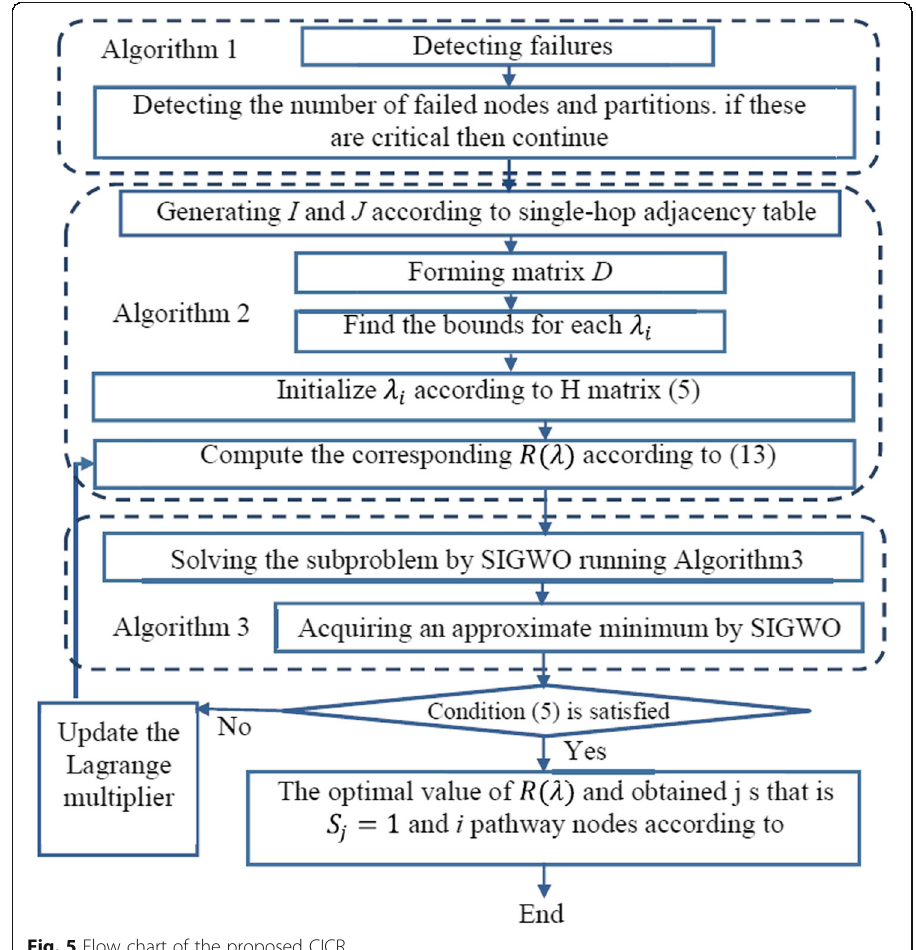
Fig. 5 Flow chart of the proposed